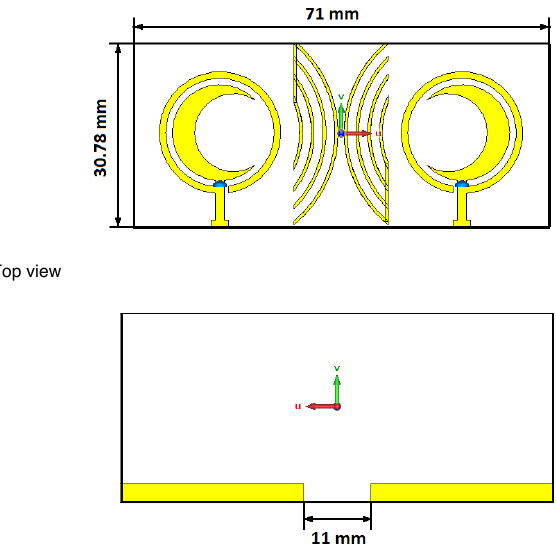
FIGURE 10. The proposed MIMO